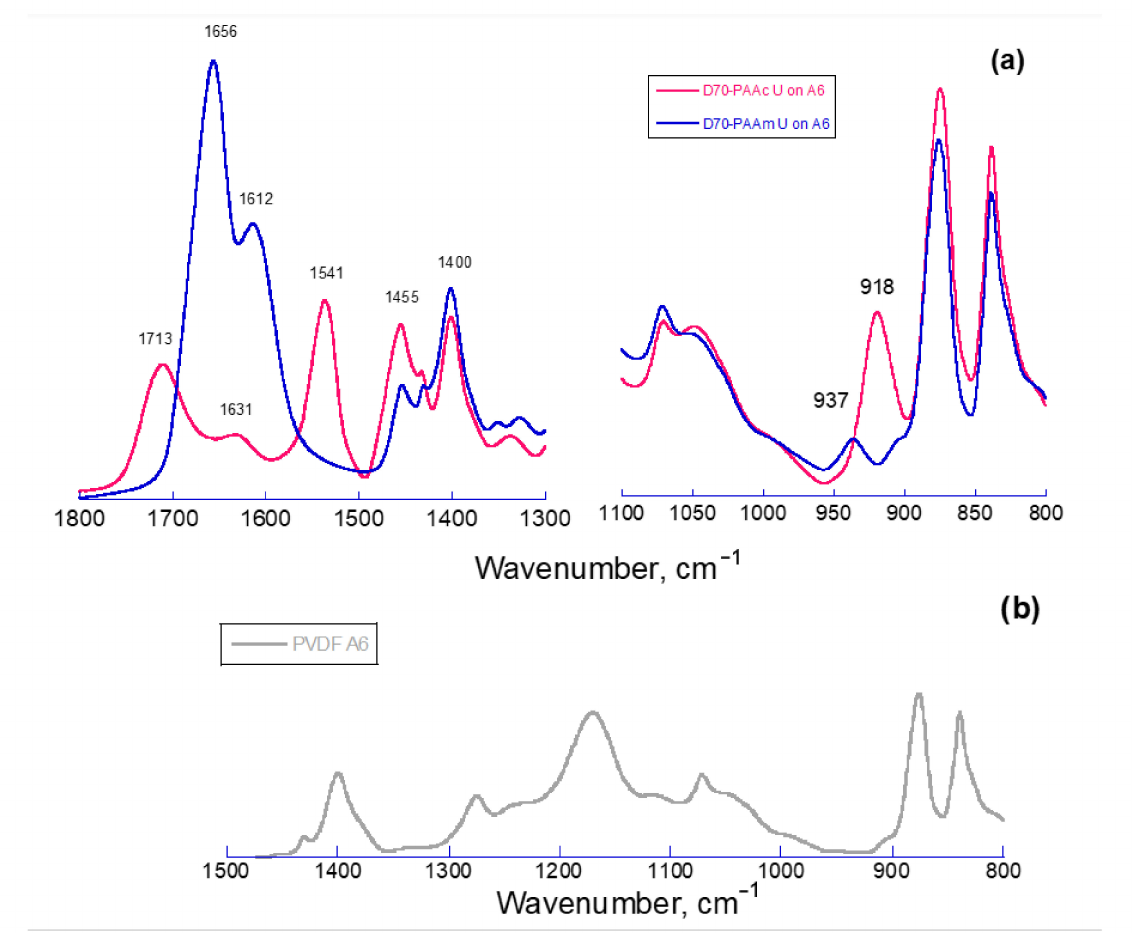
Figure 7. FTIR spectra of D70-PAAc (red) and D70-PAAm (blue) polymer–uranium complexes deposited on A6 membrane ( a ) in comparison with PVDF A6 membrane ( b